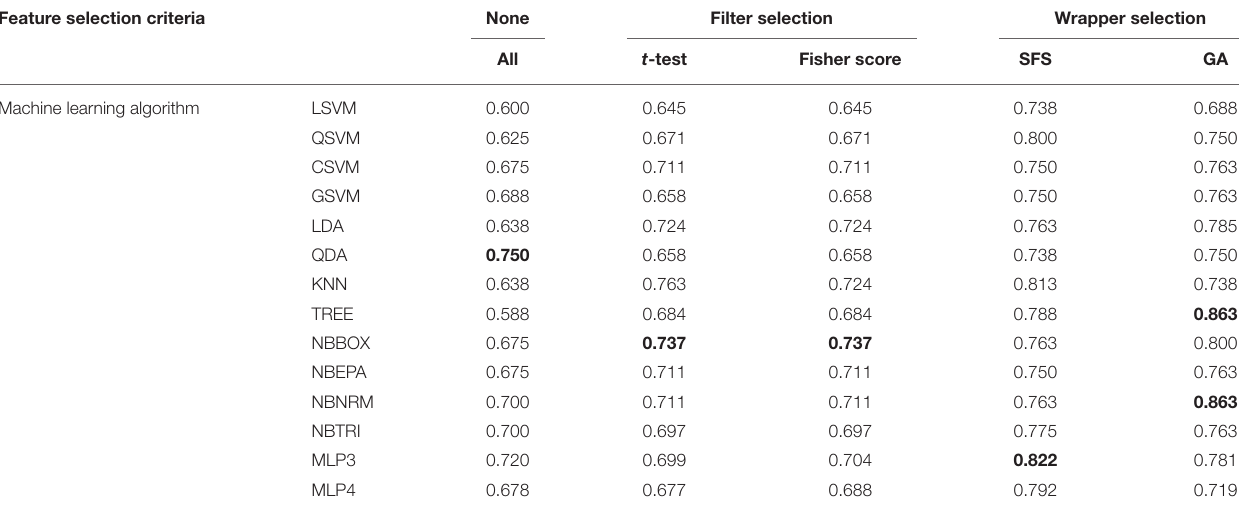
TABLE 3 | Sensitivity to impairment of models per feature selection method and classifier algorithm.